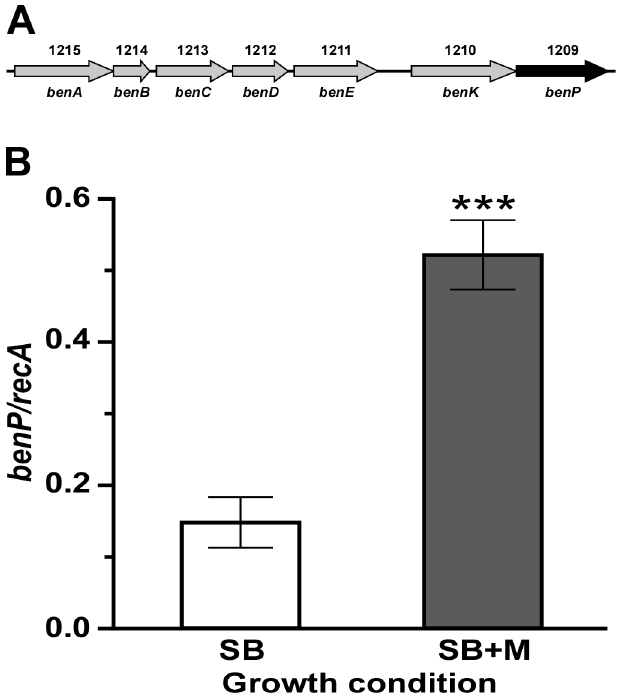
Fig 2. Differential transcription of genes coding for benzoate transport and metabolism functions in response to the presenceof mucin. (A) A1S_1215-A1S_1206genomicregioncodingfor BenA/B/C/D/E/K/ P orthologs. The arrows represent each codingregionand its direction of transcription. The grey arrows representgenes up-regulated in responseto the presenceof mucin. The black arrow indicatesthe gene ( benP ,A1S_1209)that was used to confirm the mucin-mediated up-regulation effect by qRT-PCR. Numbers abovethe arrows represent cognateA1S_ gene annotationnumbers, and gene names are indicatedbelow each arrow. (B) qRT-PCR analysisof the differentialexpressionof A1S_1209in bacterial cells culturedin SB (white bar) or SB+M (grey bar) performed using nine replicates. Significantlydifferent values ( P (cid:20) 0.001) are identifiedby three asterisks and error bars representthe standard error of each data